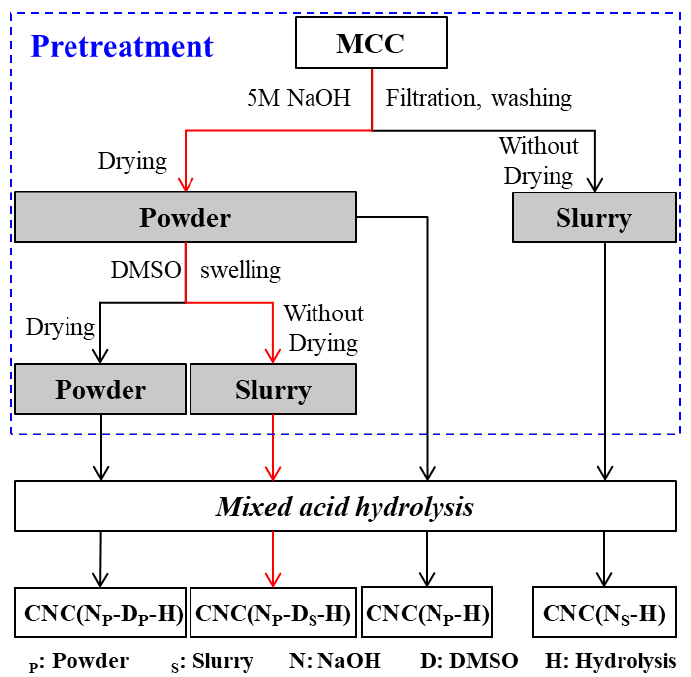
Figure 7. Pretreatment routes of MCC and its products after mixed acid hydrolysis (the common method in existing works is marked with red lines). method in existing works is marked with red